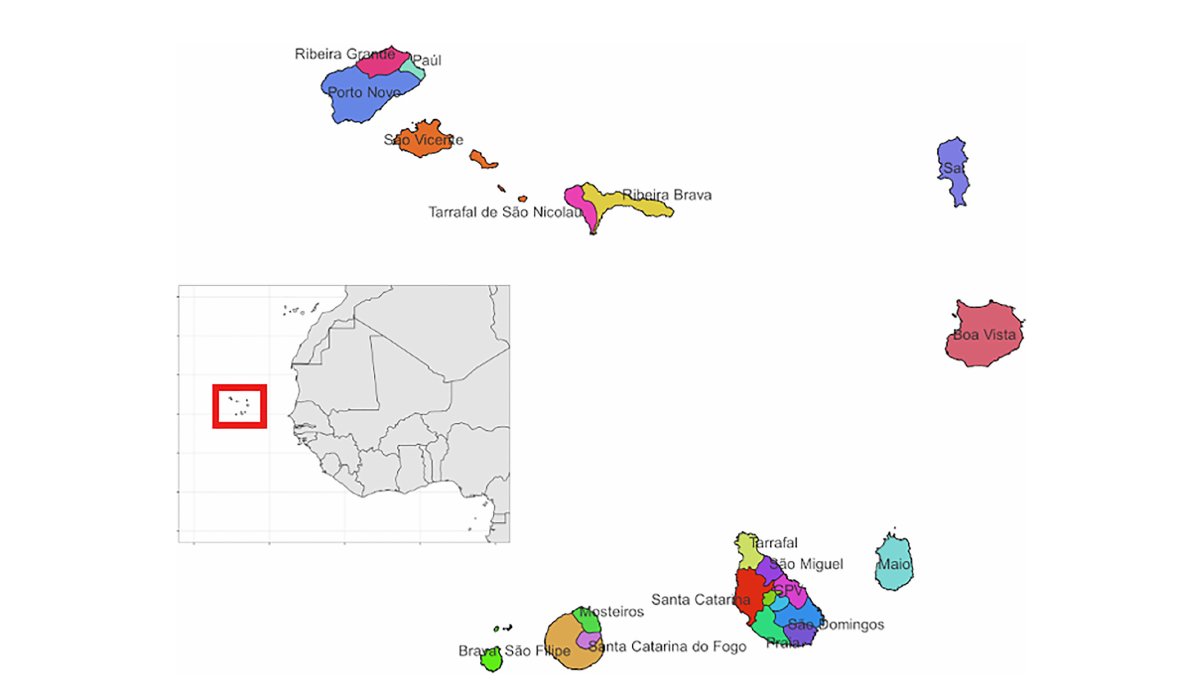
FIGURE 1 Map showing the municipalities across the islands that make up the archipelago of Cabo Verde. The municipalities are shown using different colours and labelled by the name of the municipality. The inset map highlights its location off the coast of Senegal in West